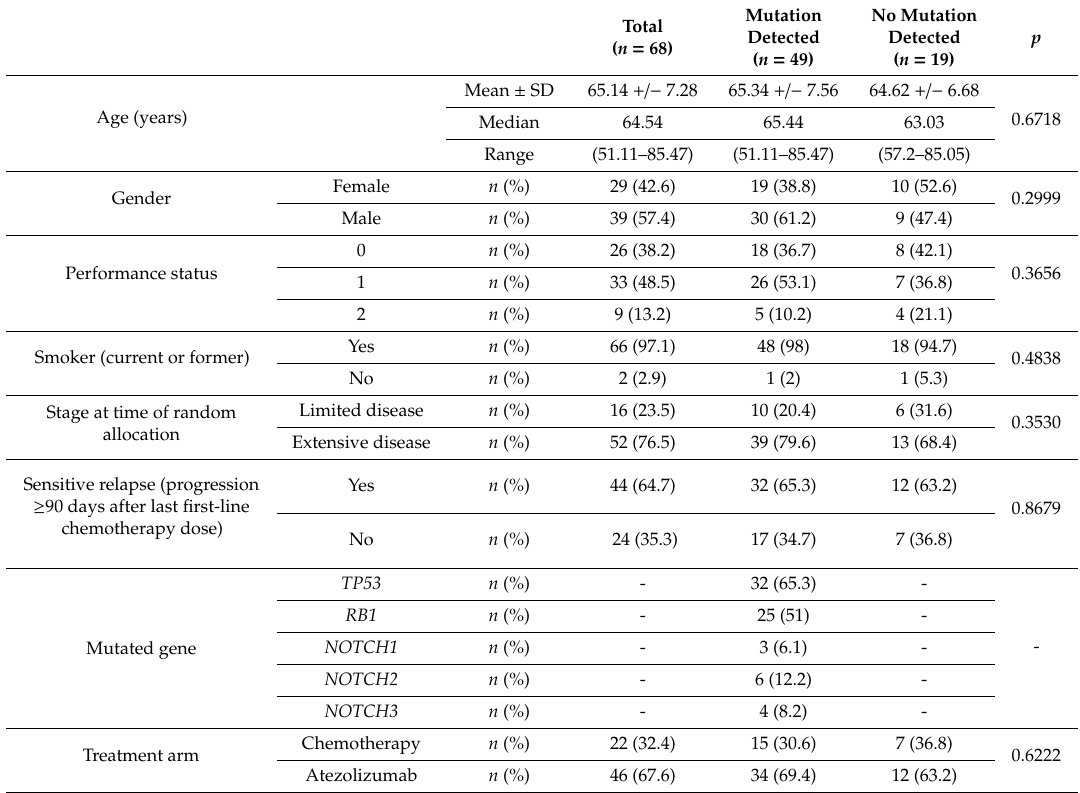
Table 1. Patient characteristics based on the detectability of